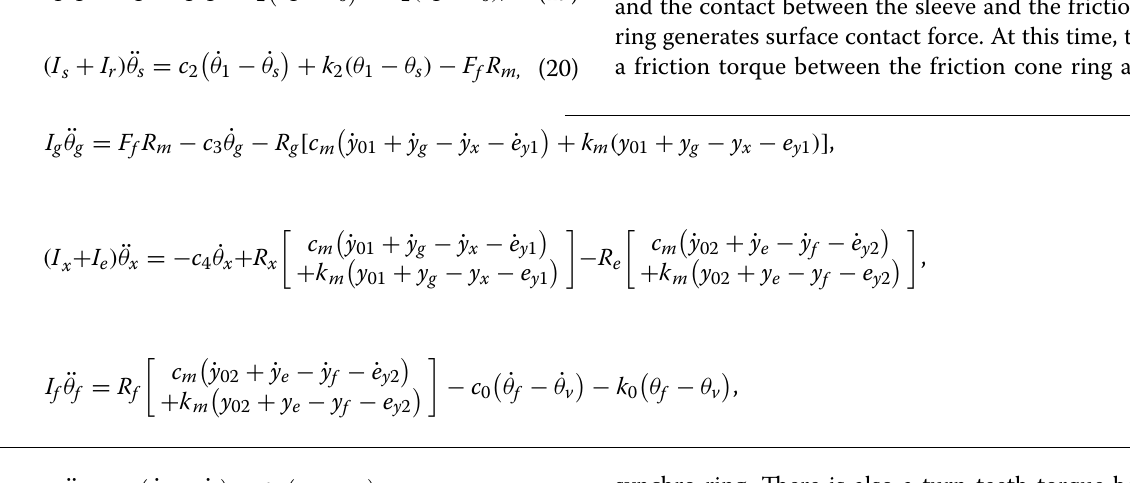
synchro ring. There is also a turn-teeth torque between the friction cone ring and the sleeve. Both friction torque and turn-teeth torque promote the elimination of the speed difference. Under the action of the helical teeth, the sleeve moves to the internal teeth hole of the friction cone ring. At the end of this phase, the shifting process proceeds to stage 4 or stage 5.